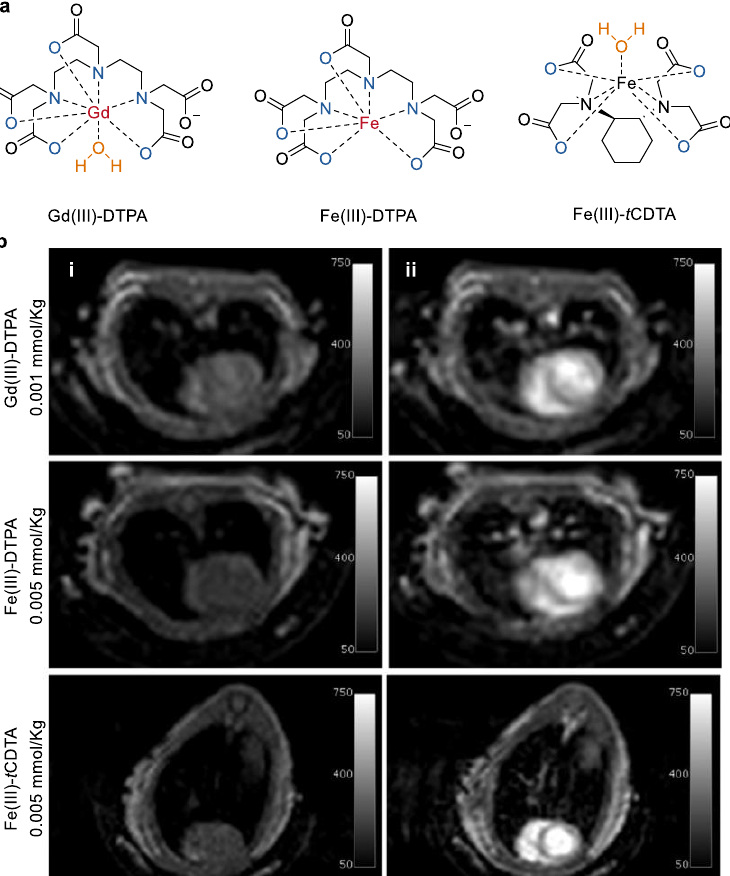
Figure 2. ( a ) Chemical structures of mononuclear Fe(III) complexes with open ligands based on DTPA and t CDTA, the reference Gd(III) – DTPA complex was also shown, and ( b ) T 1 contrast MRI of mouse hearts before ( i ) and after injection ( ii ) of Gd(III)–DTPA, Fe(III)–DTPA, and Fe(III)– t CDTA at 1.5 T